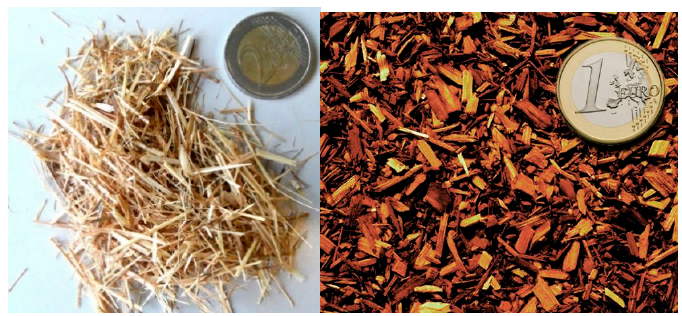
Figure 1. Pictures of the utilized biomasses.